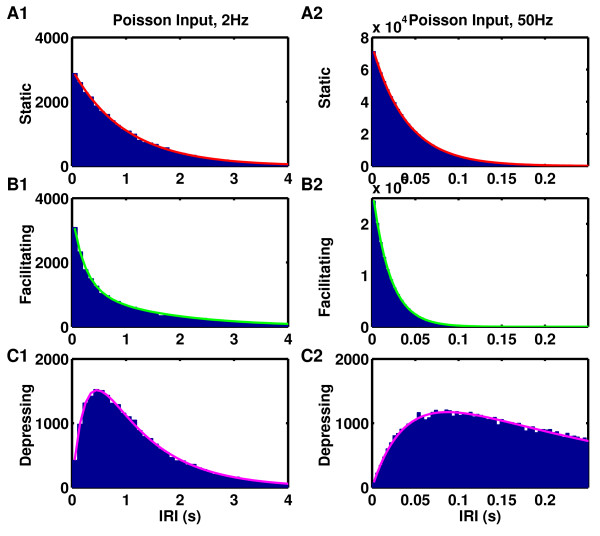
Dynamic synapses alter the distribution of interrelease intervals (IRI) of one vesicle
produced by a Poisson spike train. a1–a2 Histogram of IRIs for
static synapses is exponential (p0=0.5). b1–b2 Histogram of IRIs for a
facilitating synapse is more sharply peaked than exponential (with a CV greater than
one) (p0=0.1, fF=0.5, τF=500 ms). c1–c2 Histogram of IRIs for a
probabilistic depressing synapse has a dip at low intervals (producing a CV less than
one) (p0=0.5, τD=250 ms). a1, b1, c1 Presynaptic Poisson spike
train of 2 Hz. a2, b2, c2 Presynaptic Poisson spike train of
50 Hz